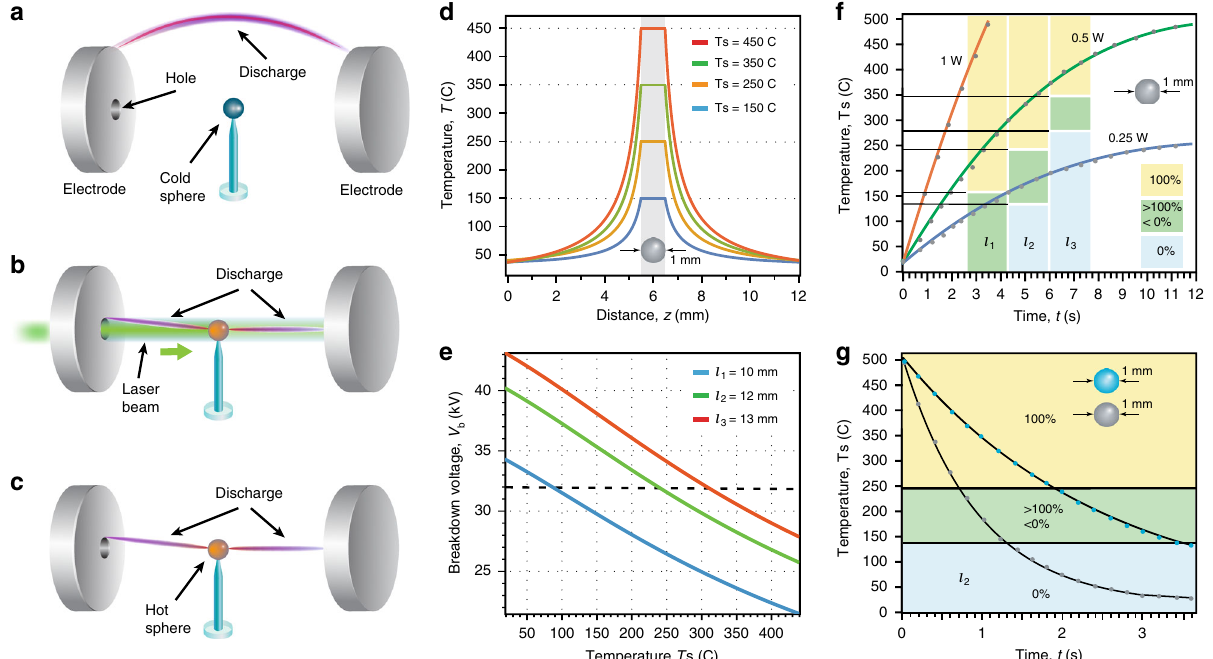
Fig. 2 The electrical discharge induced by a heated microparticle. A single microparticle is fi xed between two parallel electrodes energised close to the threshold breakdown of air. When the particle is cold, the electrical breakdown may occur along random trajectories, typically arcing close to the edges of the electrodes ( a ). Heating the sphere with a laser beam results in guiding the discharge through the sphere ( b ). The heated sphere attracts the electrical spark even after the laser is turned off ( c ). Theoretical estimation ( d ) shows the temperature distribution around the heated sphere of 1 mm diameter (Supplementary Note 2). Theoretical estimation ( e ) shows the breakdown voltage threshold for the fi xed distances between the electrodes depending on the sphere temperature in the range of our experimental conditions (For the higher temperature scale see Supplementary Fig. 3). Dashed line in e denotes DC voltage applied in our experiment ( V = 32 kV). Experimental graphs ( f , g ) detail the phenomenon as the measured temperature of a 1-mm metallic (grey) and glass (blue) sphere versus time of heating by the laser of three different powers ( f ) or cooling when the laser is of ( g ). The breakdown probabilities between the electrodes are shown in blue, green, and yellow colours, for the voltage of 32 kV and the interelectrode separation of l 1 = 10 mm, = 12 mm, and l = 13 mm. Data points are shown with circles; the line is a numerically calculated dynamics of the surface temperature l 2 1